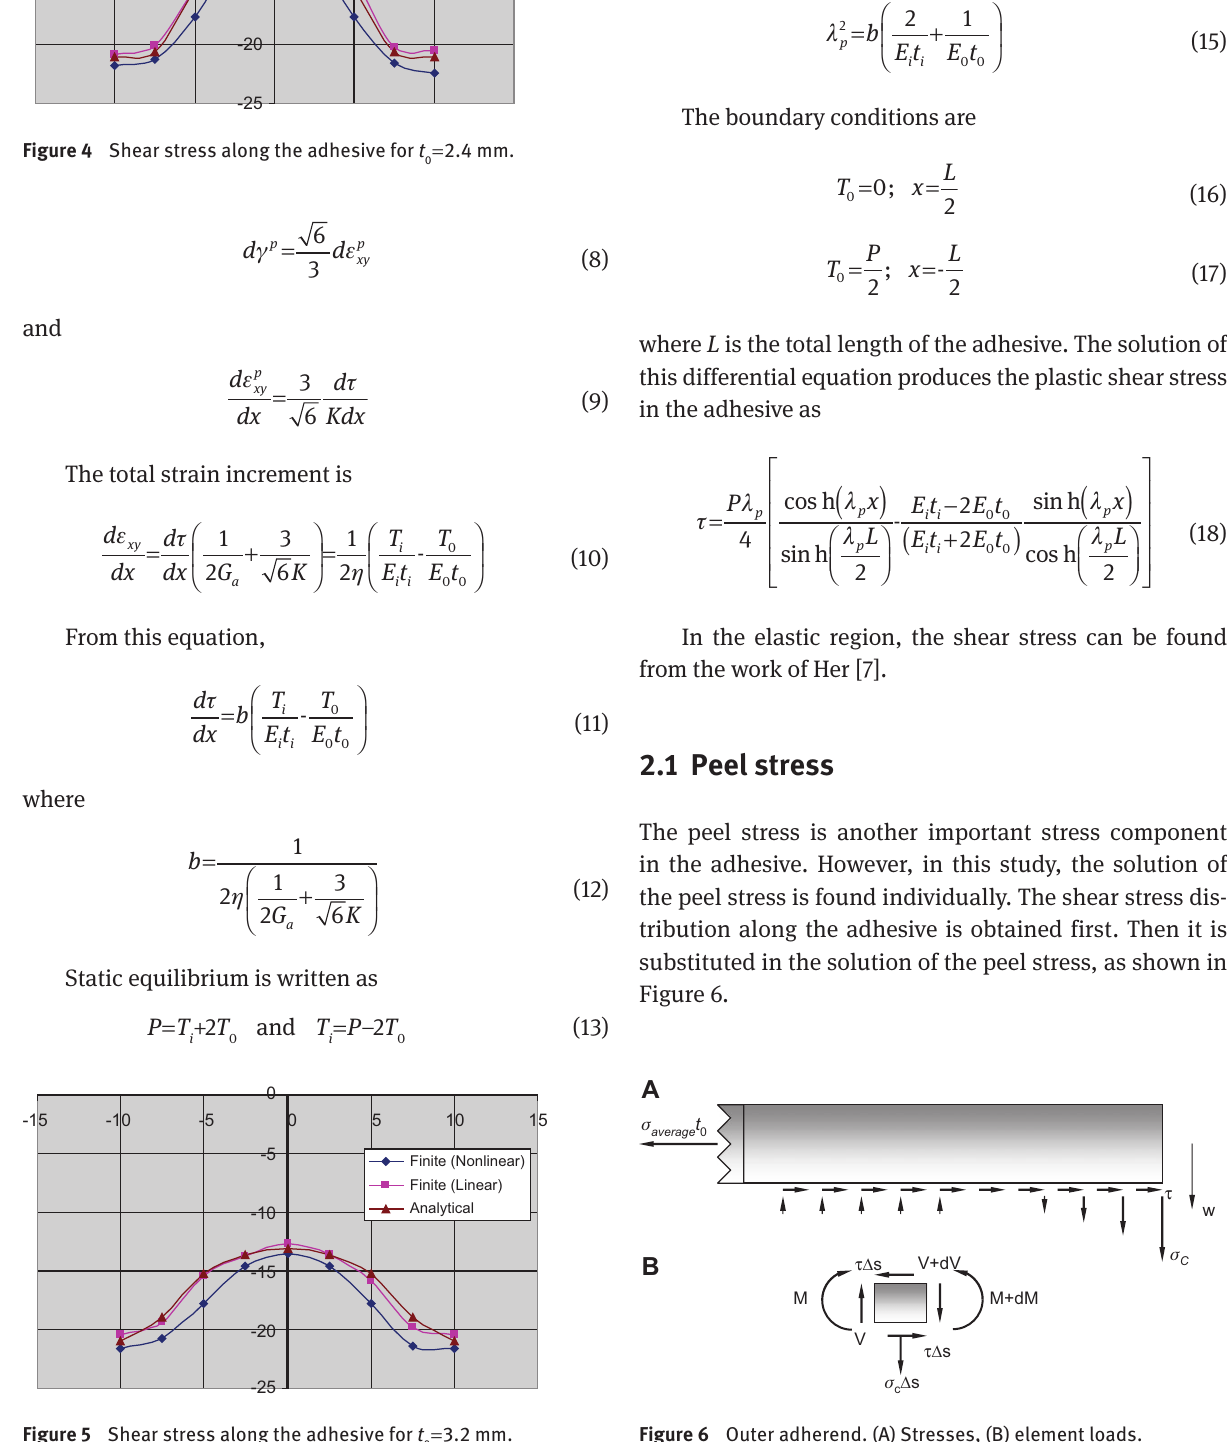
Figure 5 Shear stress along the adhesive for t